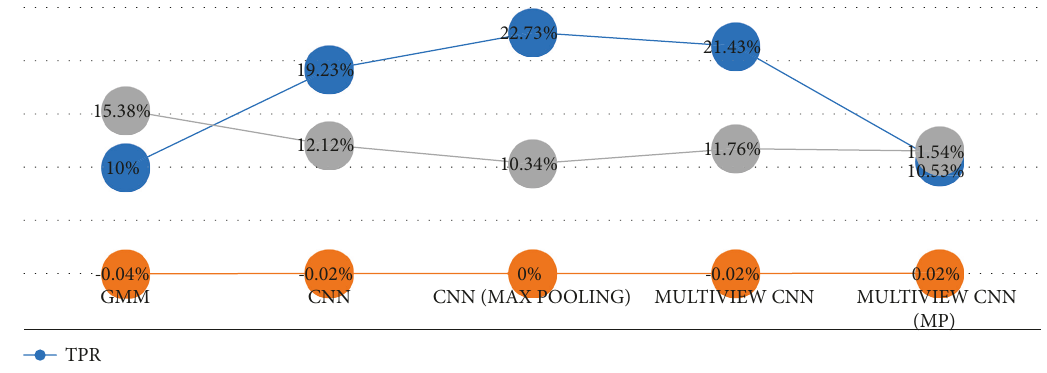
Figure 7: Changes in the metrics after the application of postprocessing.